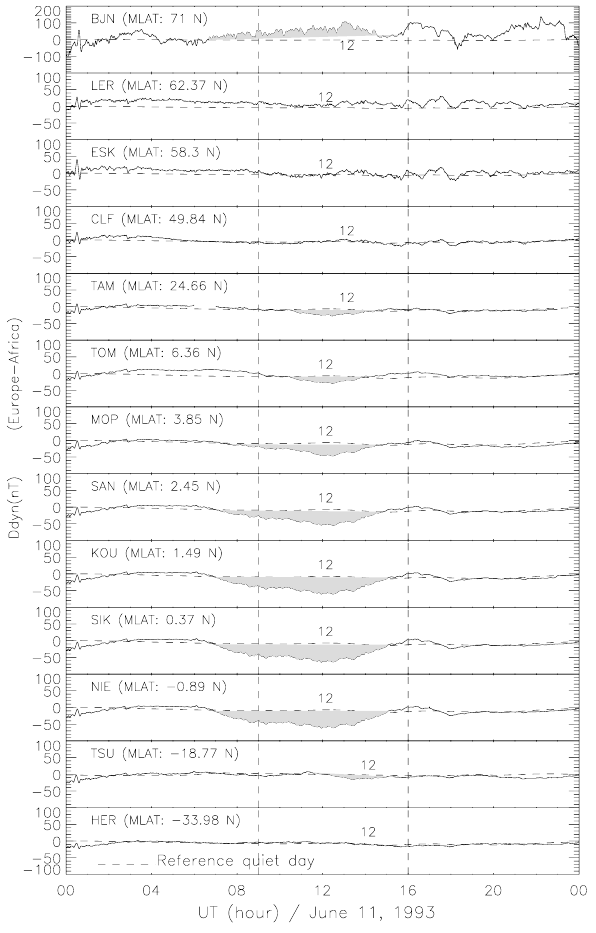
Fig. 5. Latitudinal variation of the Ddyn disturbance in the Africa- Europe sector, from high latitudes to the equator in the two hemi- spheres, on 11 June 1993. In this sector the maximum disturbance is observed during daytime around 12:00LT as indicated on the plots.